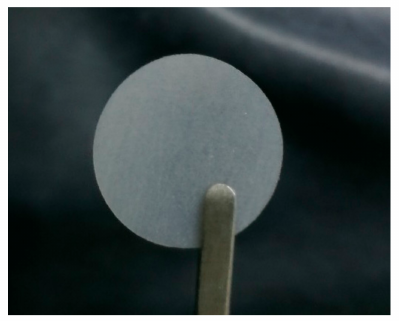
Figure 3. Cut pieces of the